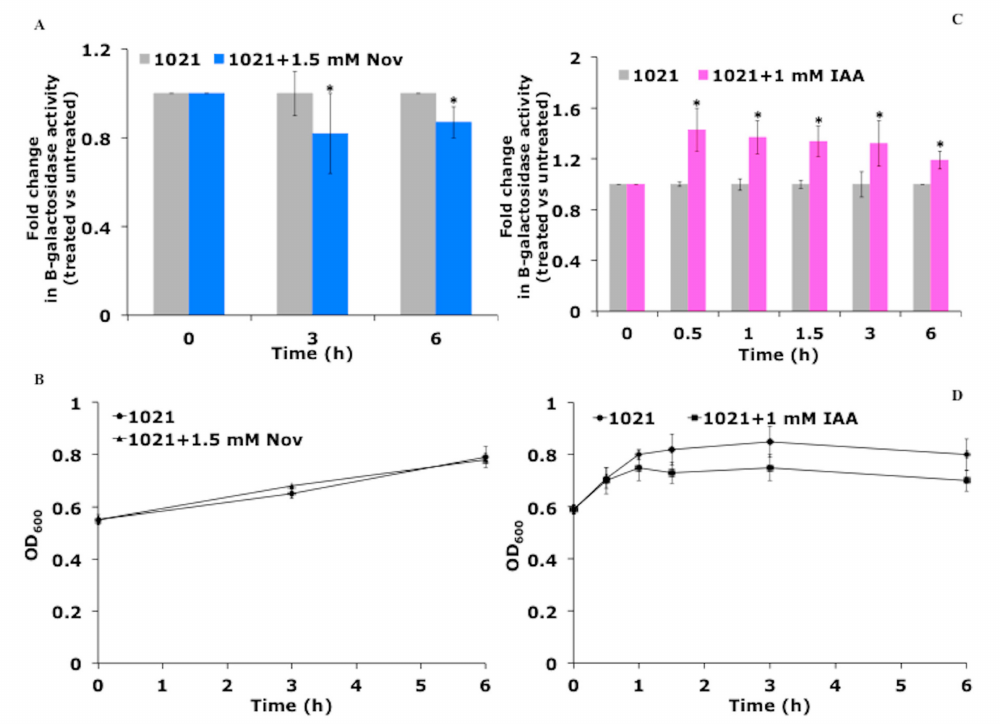
Figure 6. IAA stimulates the activity of the nitrogen-fixation regulator gene nifA . E. meliloti cells grown in nitrogen-free cultures were treated with IAA and novobiocin at final concentrations of 1 and 1.5 mM, respectively. The expression of the nifA promoter-lacZ fusion gene ( A and C ) and bacterial growth ( B and D ) were measured over time. The asterisks (*) indicate significant differences ( p < 0.05, one-way ANOVA with Tukey’s post-hoc test) between the control and cells treated with IAA and novobiocin